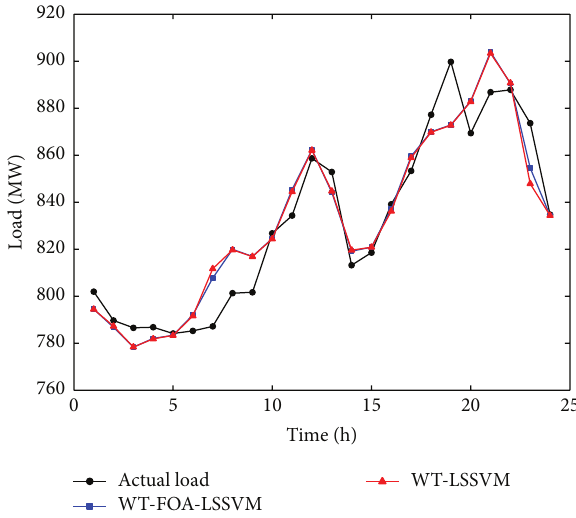
Figure 6: Actual load and forecasting results of WT-FOA-LSSVM and WT-LSSVM.